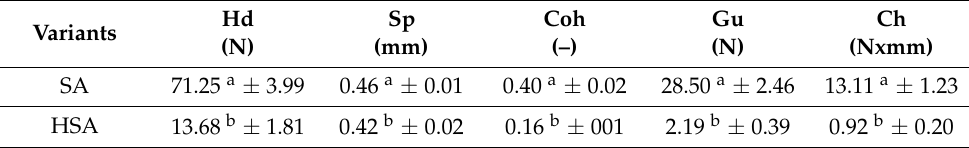
Table 3. Texture profile analysis (TPA) parameters of sodium alginate and